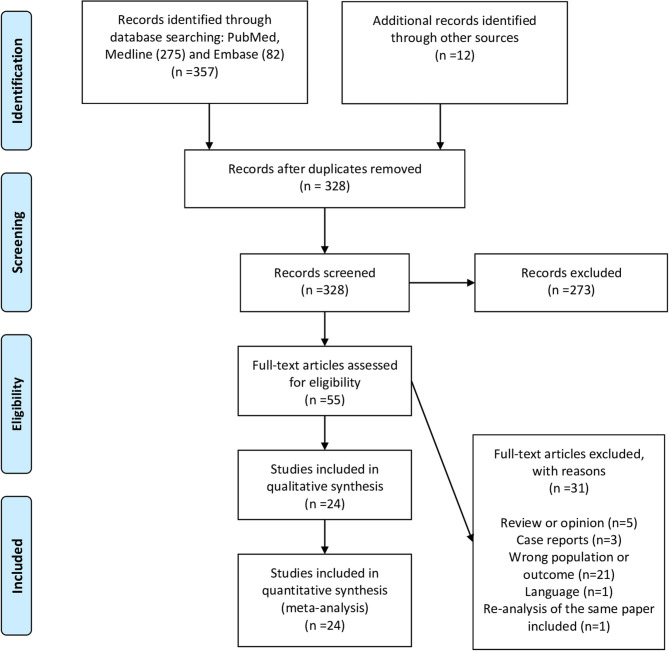
PRISMA flow diagram.